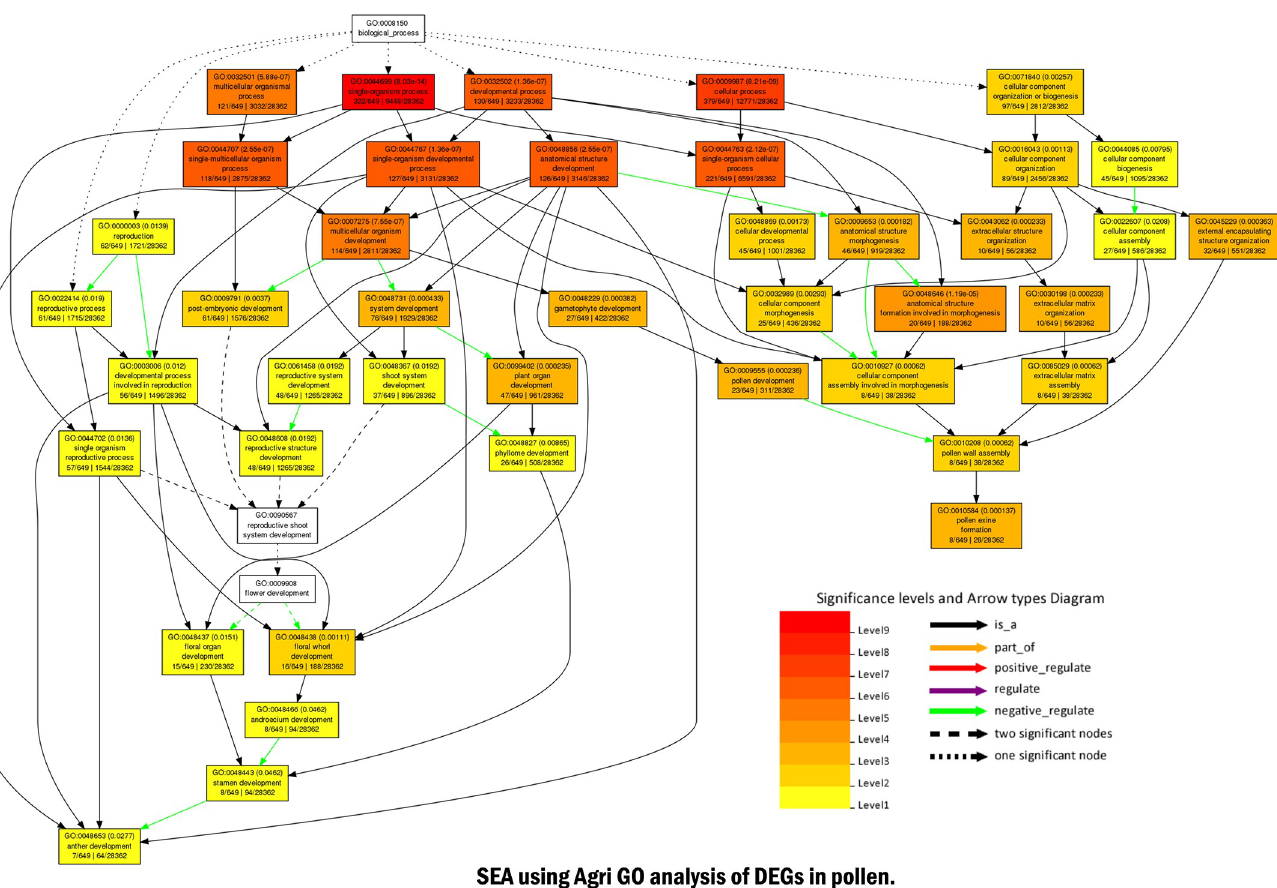
Fig 2. Agri GO analysis of DEGs in floral buds. Singular enrichment analysis was performed in AgriGO v2 to identify enriched gene ontologies associated with pollen developmental processes. Each box shows the GO term number, the p-value in parenthesis, and GO term. The pair of numerals in the left represents the number of genes in input list associated with that GO term and number of genes in the input list. The pair of numerals in the right represents the number of genes associated with a targeted GO term in the Gossypium database and a total number of Gossypium genes with GO annotations in the Gossypium database. Colour and design of arrow indicate the effect of pathways. Box colors indicate levels of statistical significance: yellow = 0.05; orange = e − 5; and red = e − 9.